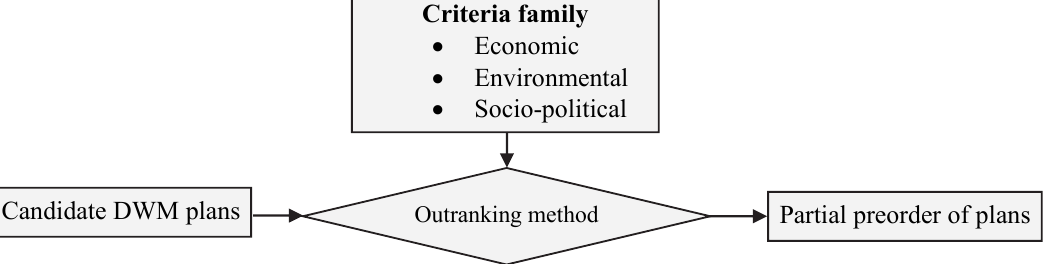
Fig. 2. General schema of the